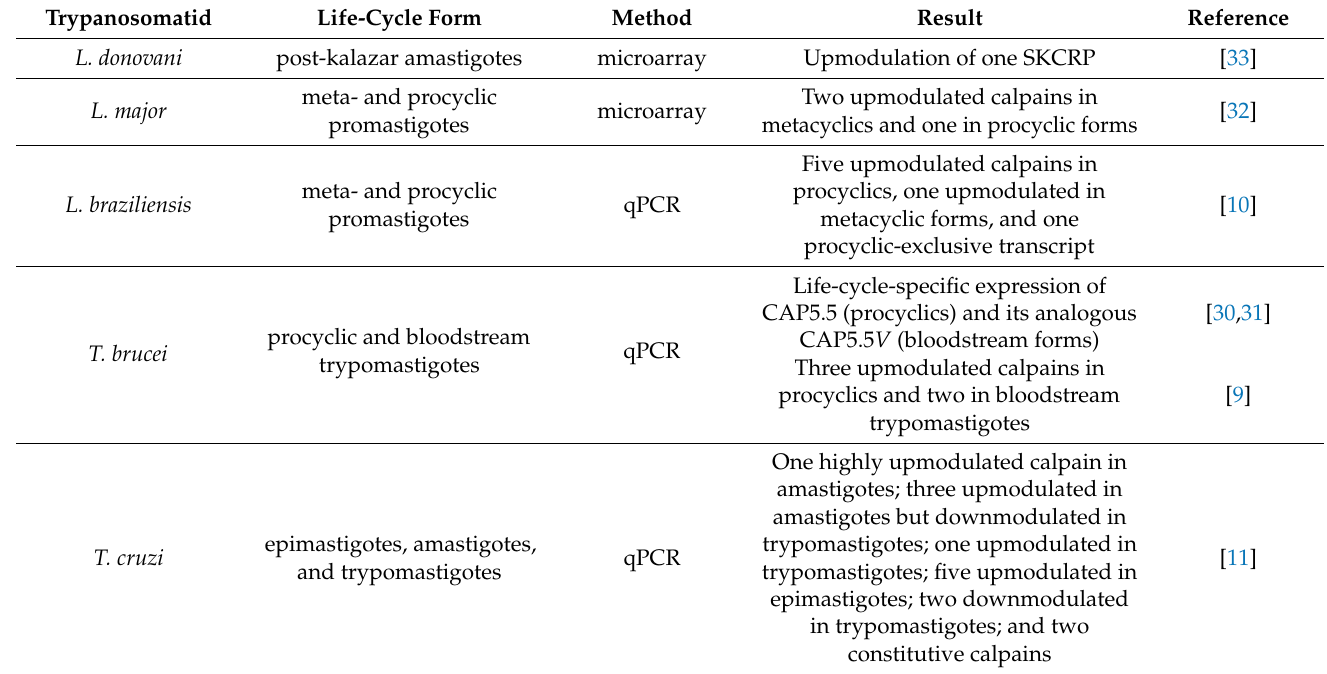
Table 2. Gene expression findings of trypanosomatid